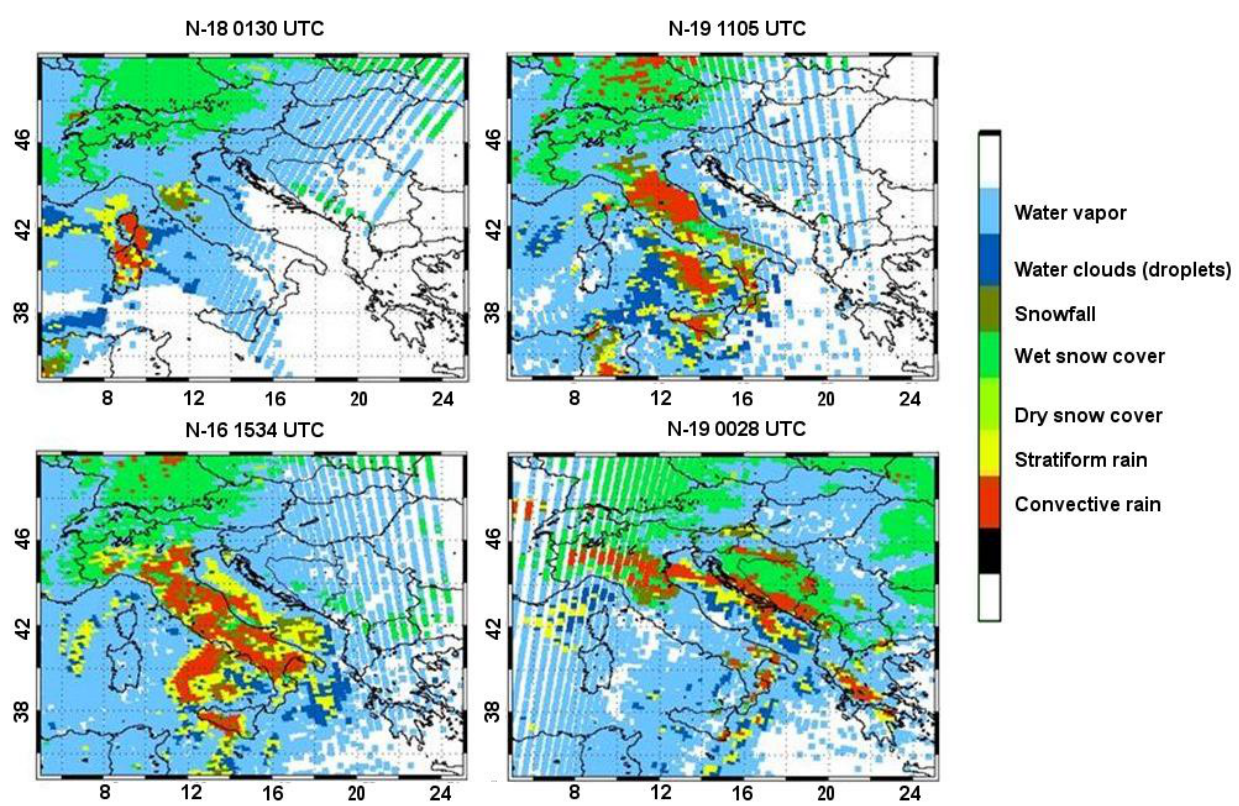
Figure 5. 9–10 March 2010. Precipitation and snow cover maps from the 183-WSL algorithm [58] for a snow blizzard over